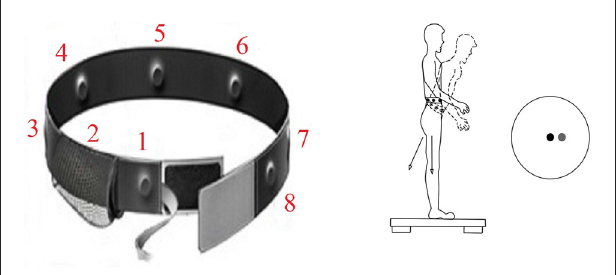
FIGURE 4 | At left is a version of the sway cueing belt, which supplies vibrotactile warnings of sway in eight directions. As the center of gravity moves forward, the forward tactor is activated similar to a rumble strip alerting a car driver when he is running off the road. At right is a schematic of forward sway of the body away from center of sway platform pressure (black circle) which triggers activation of front tactor (relative direction of sway motion warning indicated by the gray